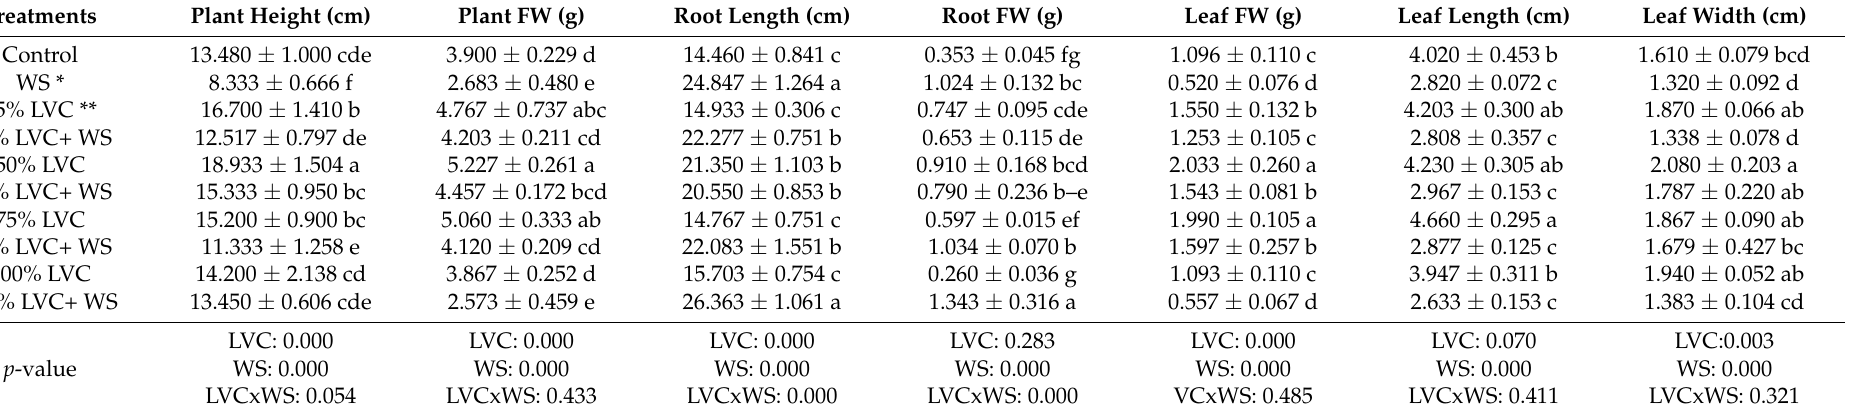
Table 2. Effects of liquid leachate obtained from vermicompost (25, 50, 75, and 100%) on some agronomic attributes of sweet basil ( O. basilicum L.) under drought stress